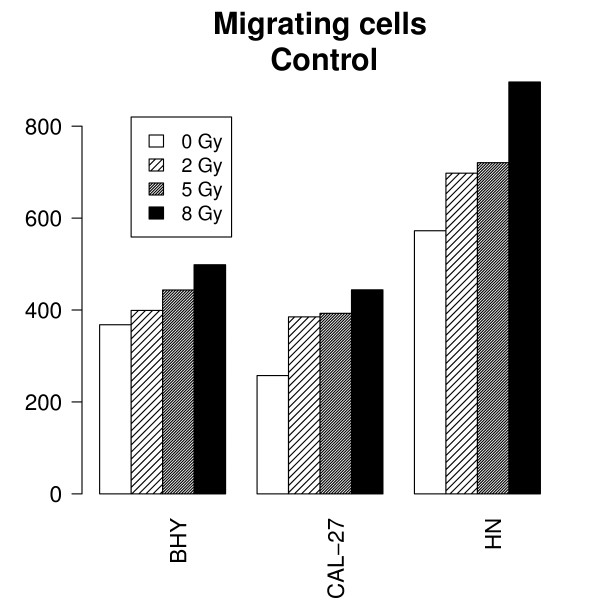
Radiation induced migration. The number of migrating cells after irradiation with 0, 2, 5, and 8 Gy were determined by the wound healing assay for the HNSCC cell lines BHY, CAL-27 and HN. Cells were grown to confluent monolayers, wounded by scratching the surface as uniformly as possible with a pipette tip and afterwards irradiated. The number of migrated tumor cells in the wound was determined. The means and standard errors of 9 tests per time point and dose were calculated after 12 hrs. An increased time dependent migration of tumor cells after irradiation was observed after treatment compared to the control group of not irradiated cells (p < 0.009).